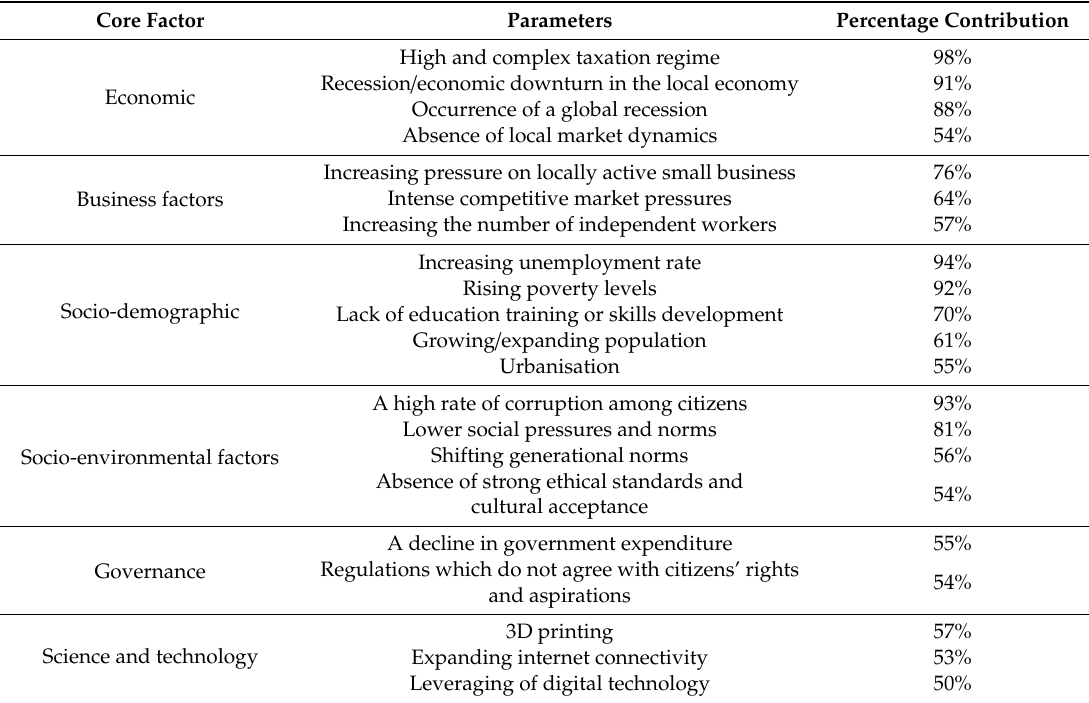
Table 5. Core informal economy parameters